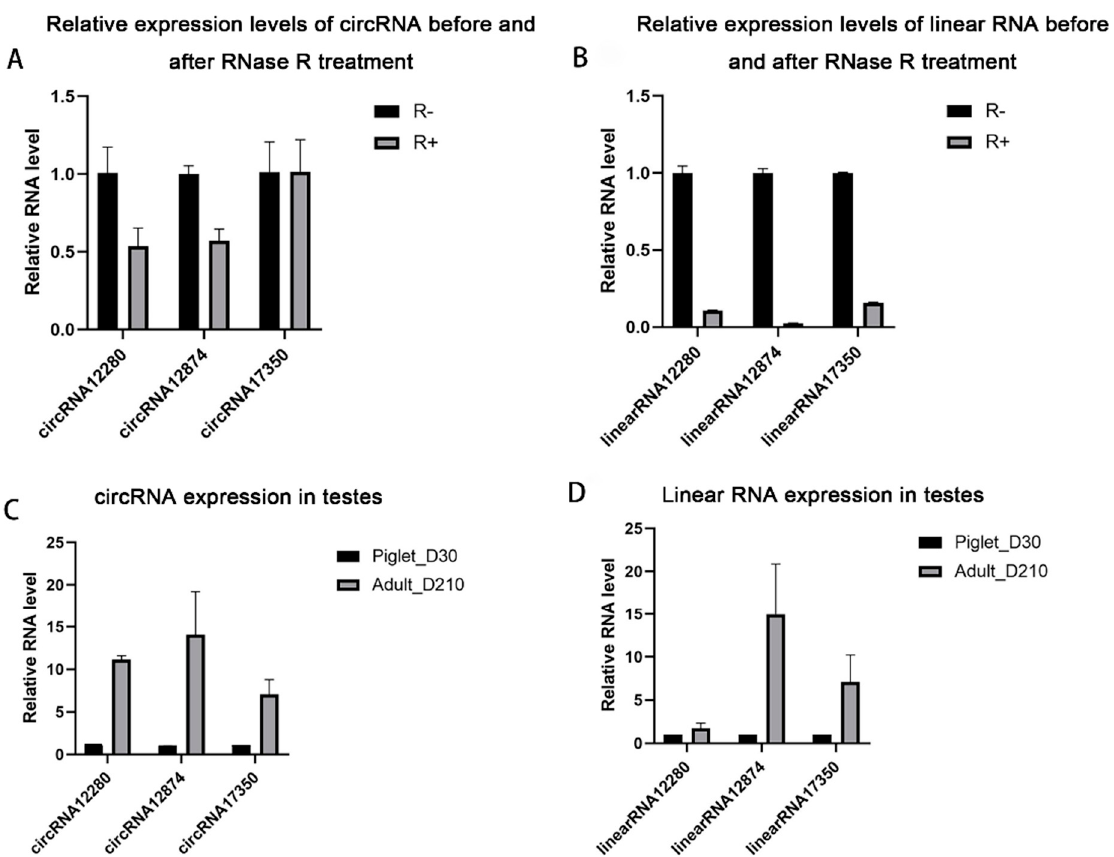
Figure 7. Validation of differentially expressed circRNAs in young (Piglet-D30) and sexual mature (Adult-D210) boar testes. Relative expression levels of circRNAs before and after RNase R treatment ( A ). Changes of the relative expression levels of linear RNA corresponding to circRNAs before and after RNase R treatment ( B ). Relative expression changes of circRNAs in testes before and after sexual maturity ( C ). Changes of the relative expression levels of linear RNA corresponding to circRNAs in the testes before and after sexual maturity. R − and R+ represent RNA treat with or without RNase R. The data were normalized against endogenous housekeeping gene EF1 α 1 and the Value for the blank control was set as one ( D ).